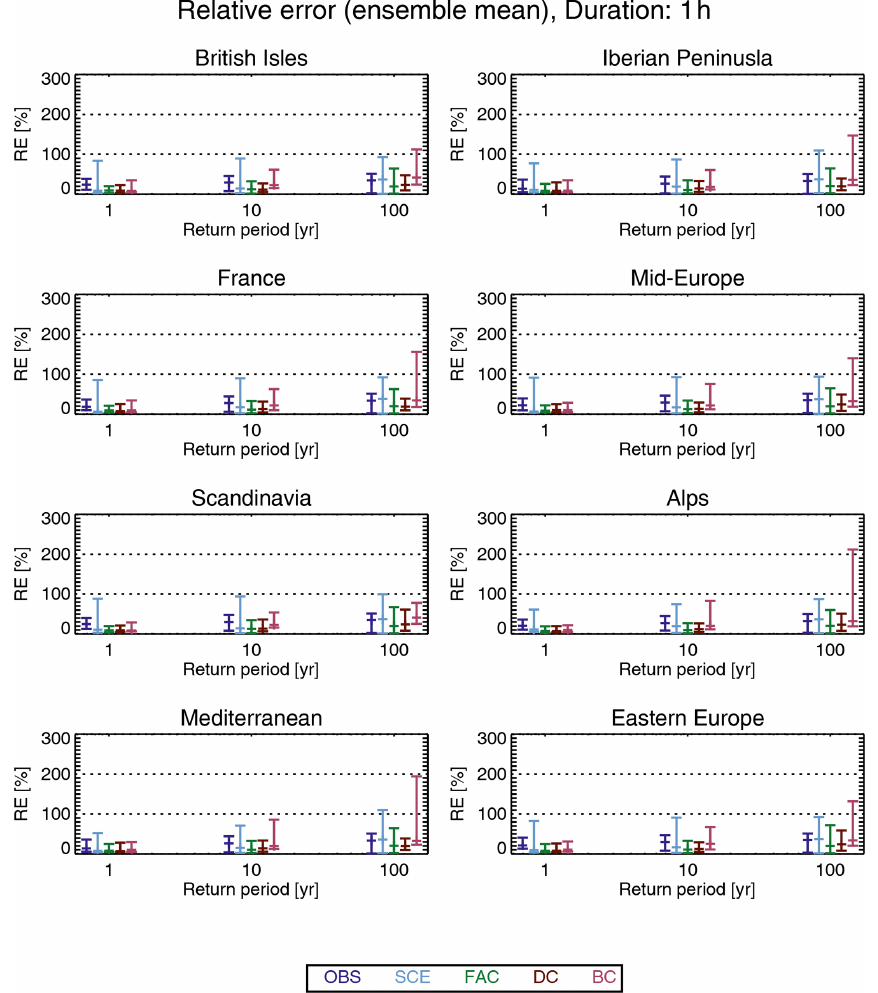
Figure 9. As in Fig. 6 but for the inter-model cross-validation against ensemble